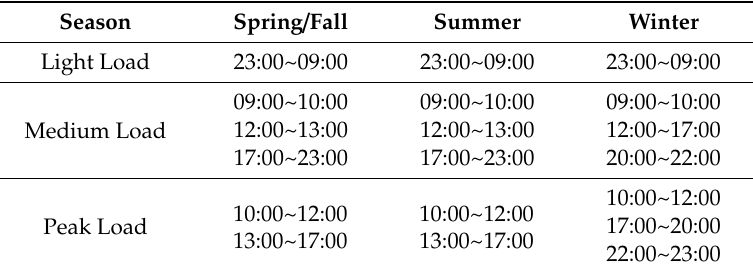
Table 2. ToU tari ff in South Korea